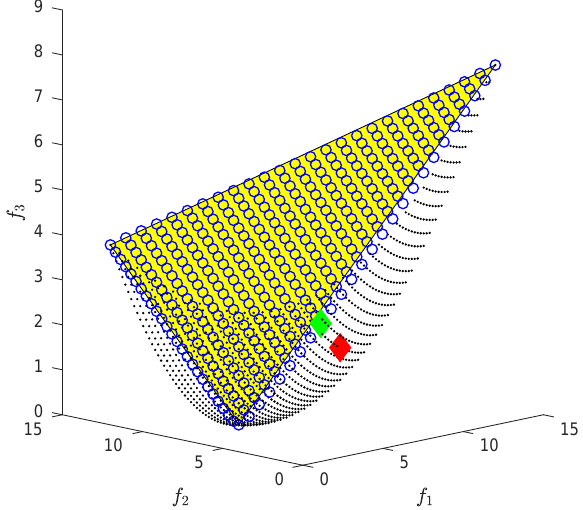
Figure 4. Example of a three-objective problem where the knee solutions defined by (12) and (16)